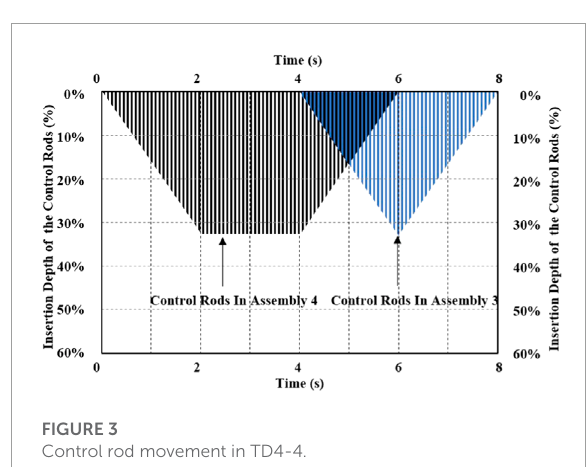
FIGURE 3 Control rod movement in